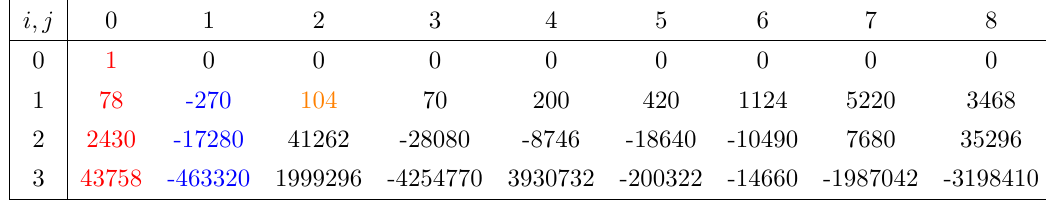
Table 15 . Series coefficients c i,j for the one-string elliptic genus of n = 1 E 6